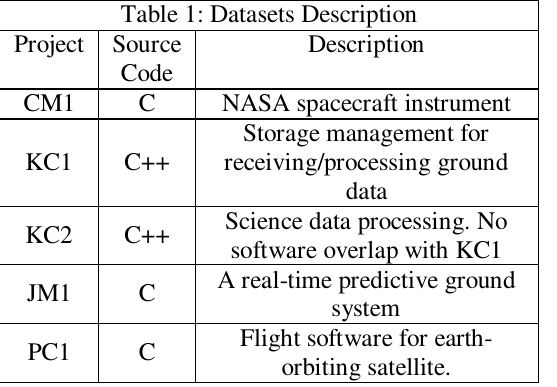
Table 1: Datasets Description